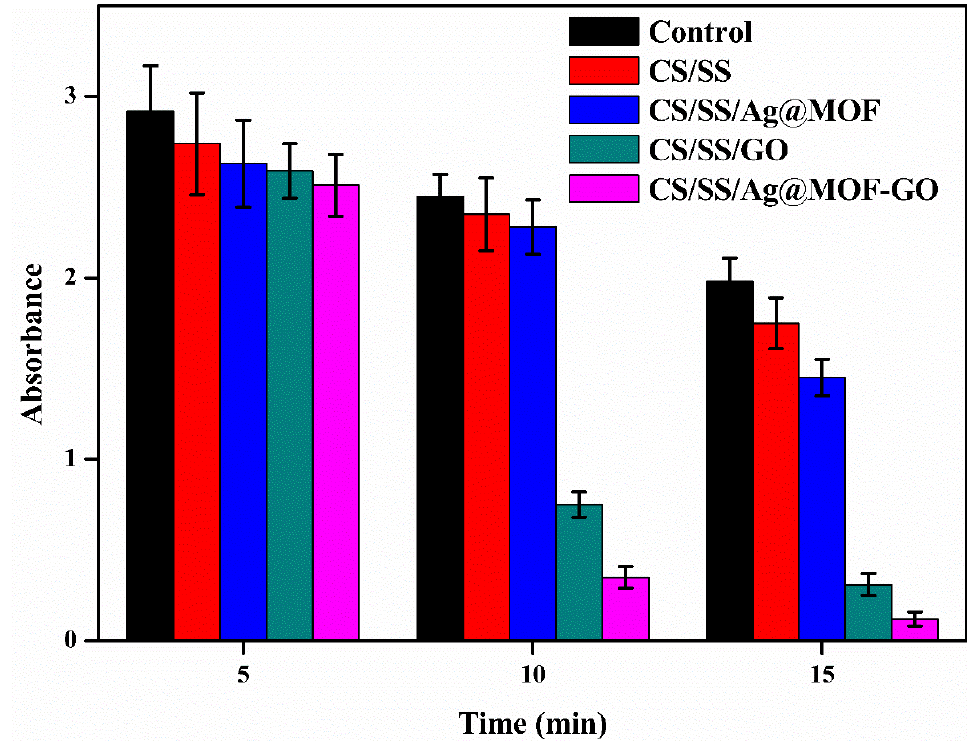
Figure 4. Blood clotting kinetics of the composite dressing compared to the control.